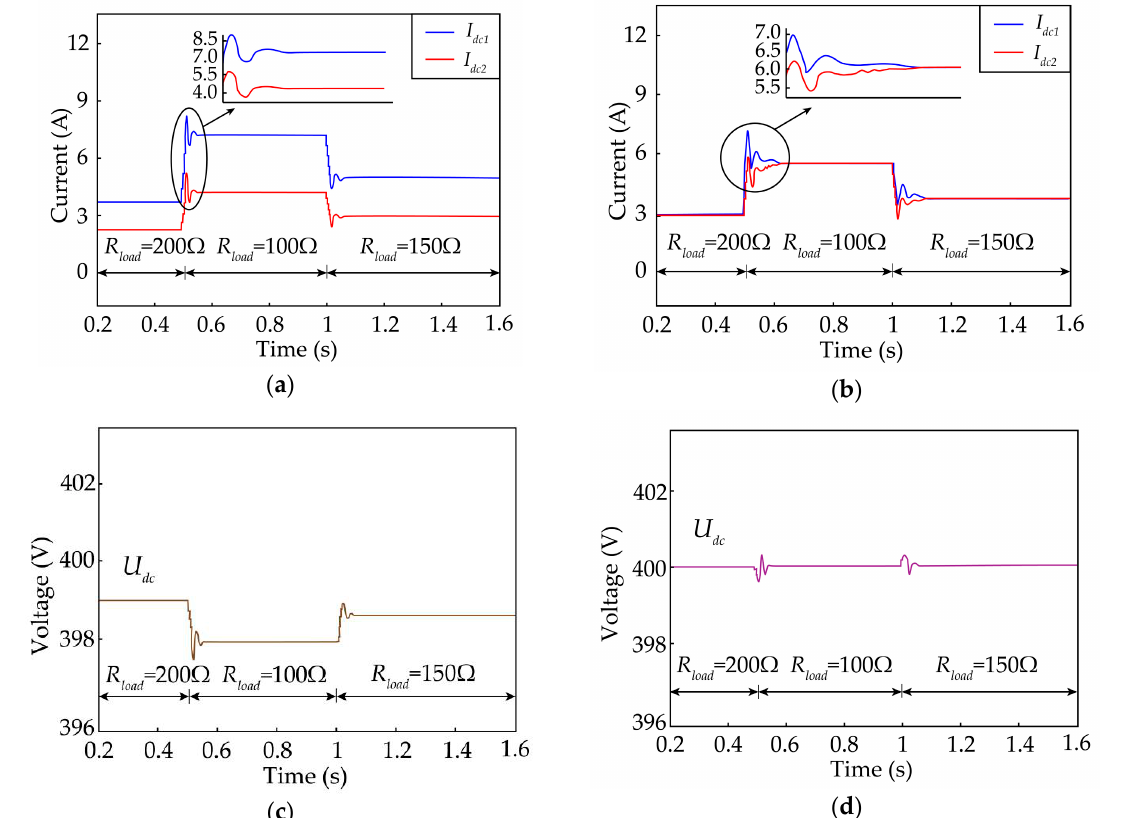
Figure 16. Simulation results of Case 3. ( a ) The current distribution under the traditional algorithm; ( b ) the current distribution under the proposed algorithm; ( c ) the bus voltage under the traditional algorithm; ( d ) the bus voltage under the proposed algorithm.